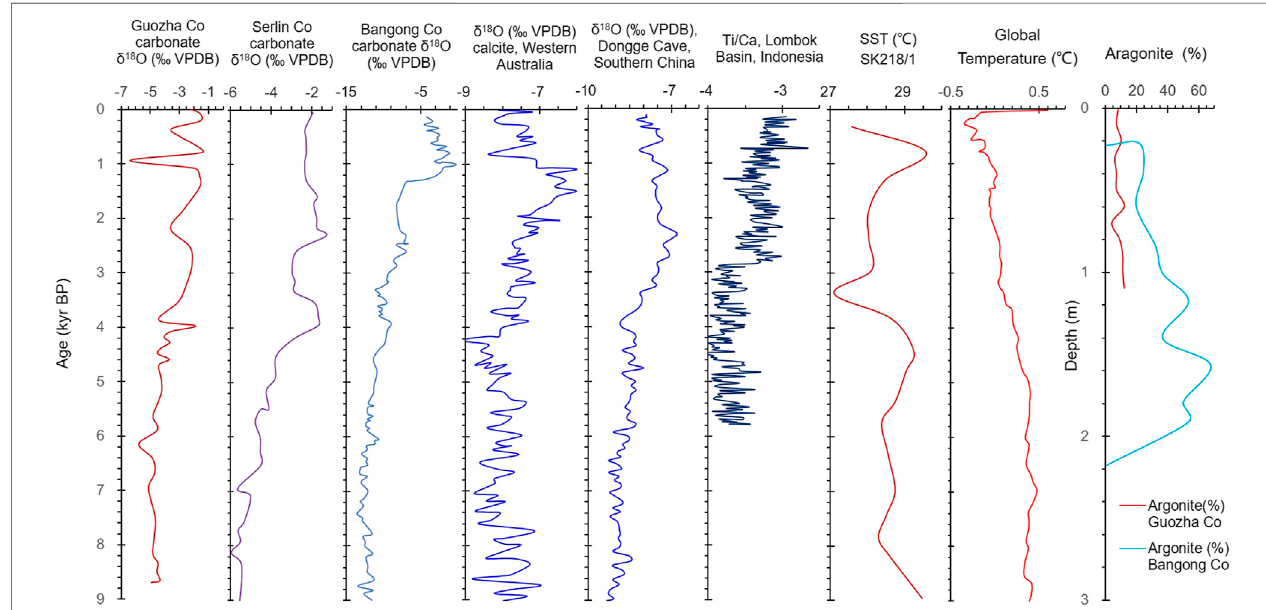
Frontiers in Earth Science |